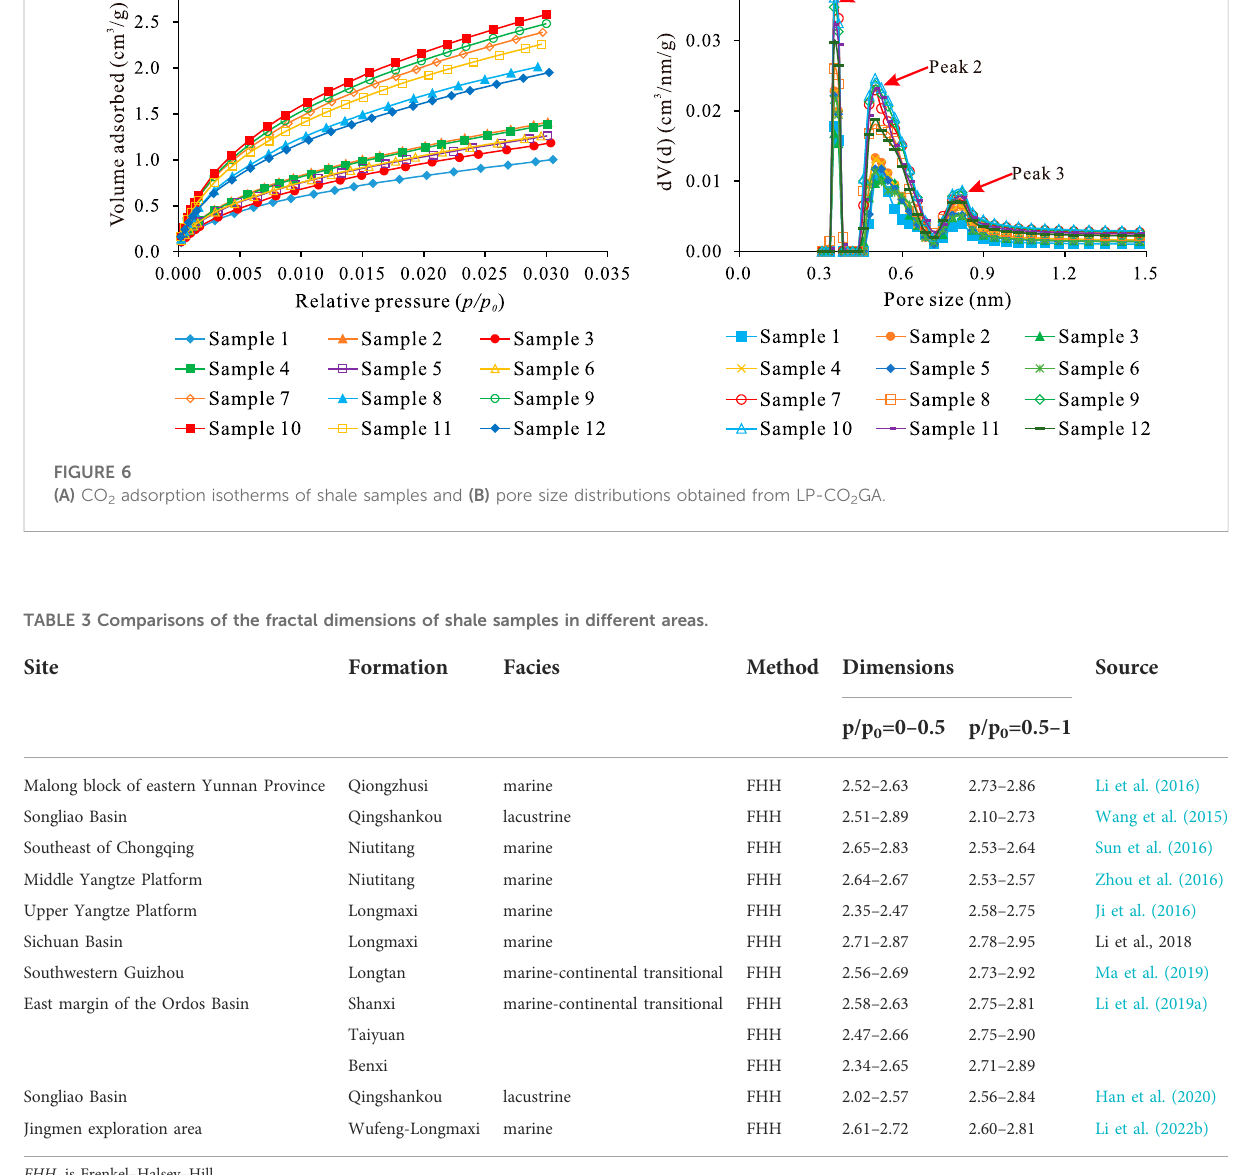
curves of ln ( v ) and ln ( ln ( p 0 / p )) of N 2 adsorption samples at low temperature. In the two intervals where two fi tting line segments with obviously different slopes due to different adsorption mechanisms. The fi tting line segments of these two segments have a good linear fi tting